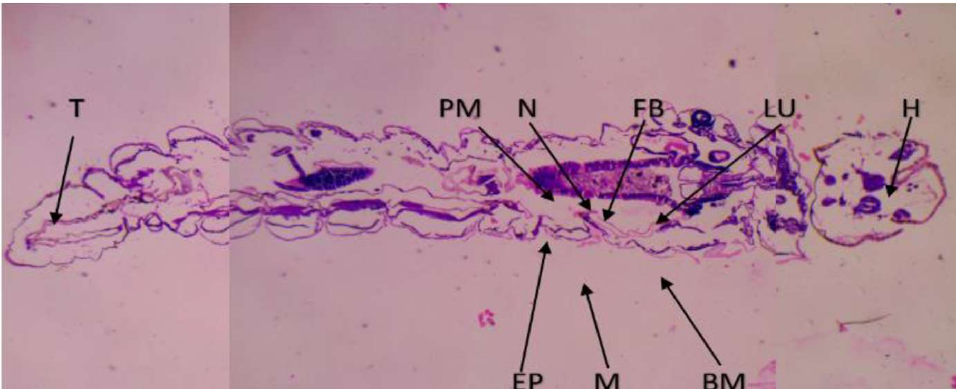
Figure 7. Histopathological images of fourth-instar larvae of non-treated Ae. aegypti larvae (epithelial cells—EP; peritrophic membrane—PM; food bolus—FB; basement membrane—BM; muscles—M; nucleus—N; LU—gut lumen).